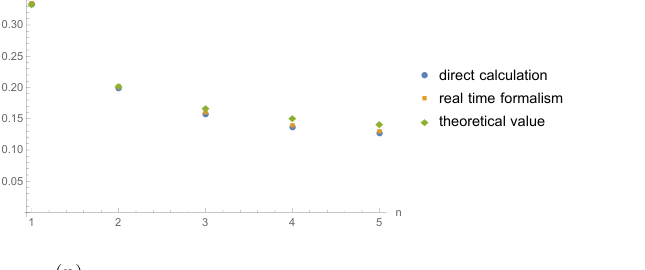
Figure 4 . The coe(cid:14)cient g ( n ) in (5.17) as a function of n . We show the values of g ( n ) AB by the direct calculation developed in this paper and the real time formalism, and the theoretical values g ( n ) j d =2 in AB